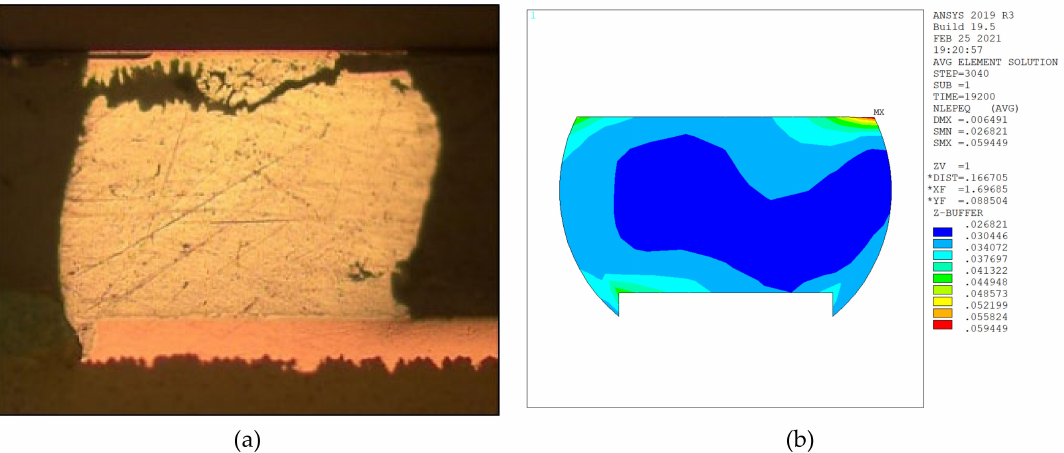
Figure 11. Failure point of solder joint after onboard thermal cycling testing (OBTCT): ( a ) Cross-section view; ( b ) equivalent inelastic strain distribution.